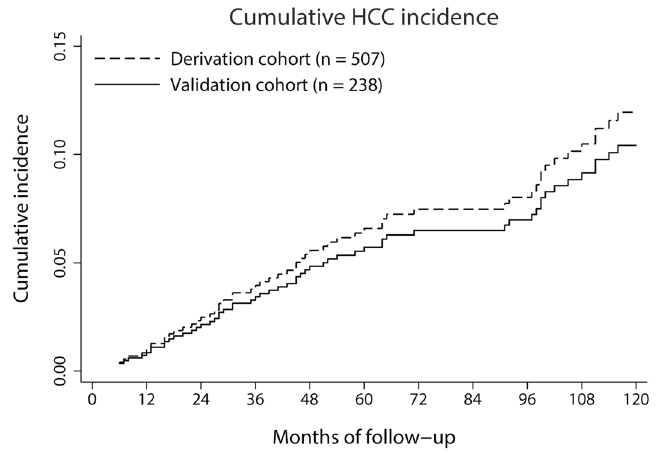
Figure 1. Cumulative incidence functions for HCC in the derivation and validation cohorts.